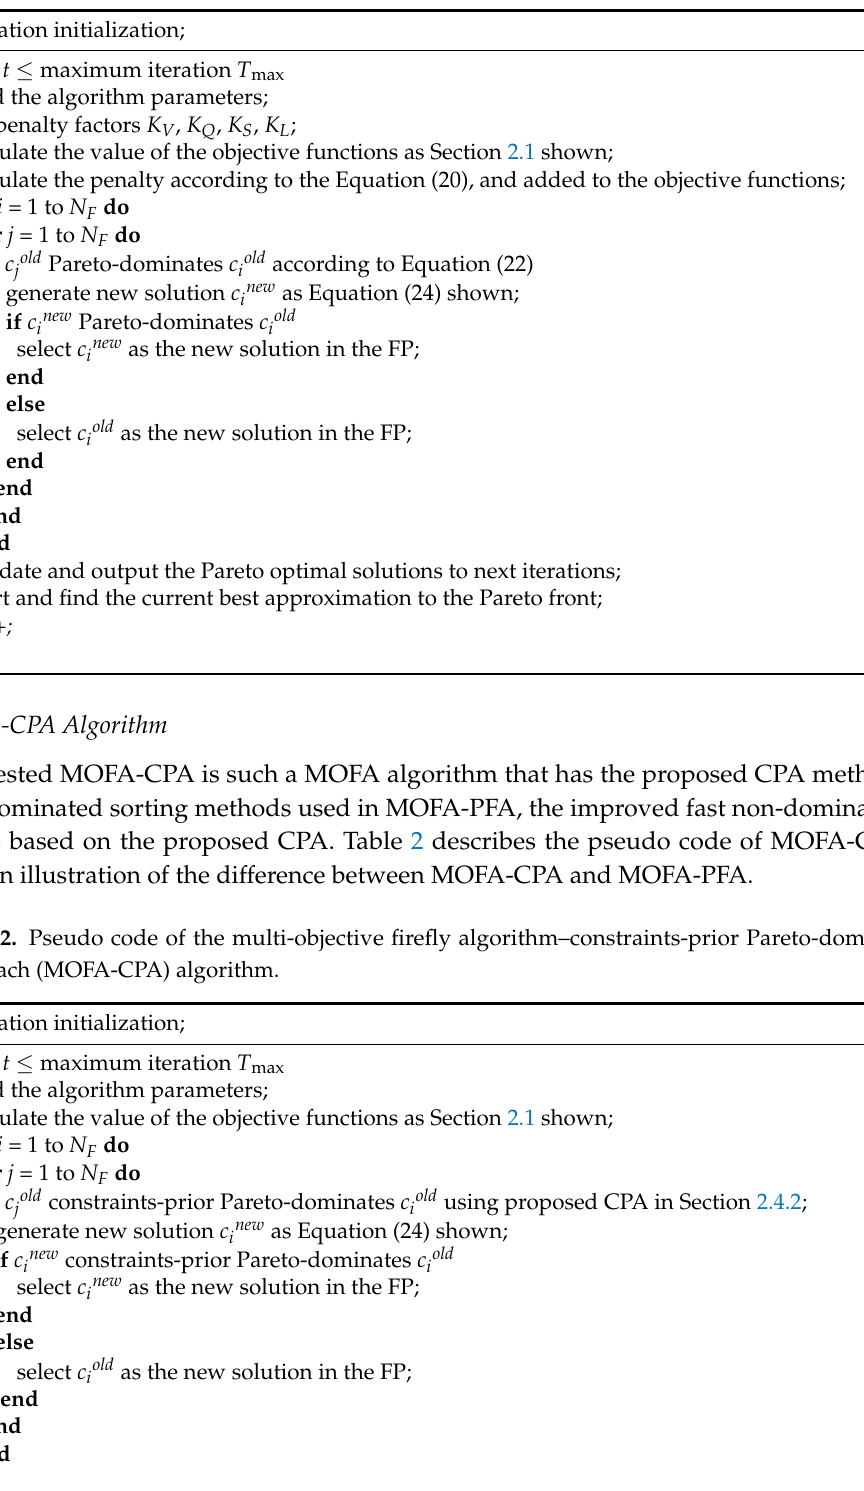
Table 1. Pseudo code of the multi-objective firefly algorithm–penalty function algorithm (MOFA-PFA).